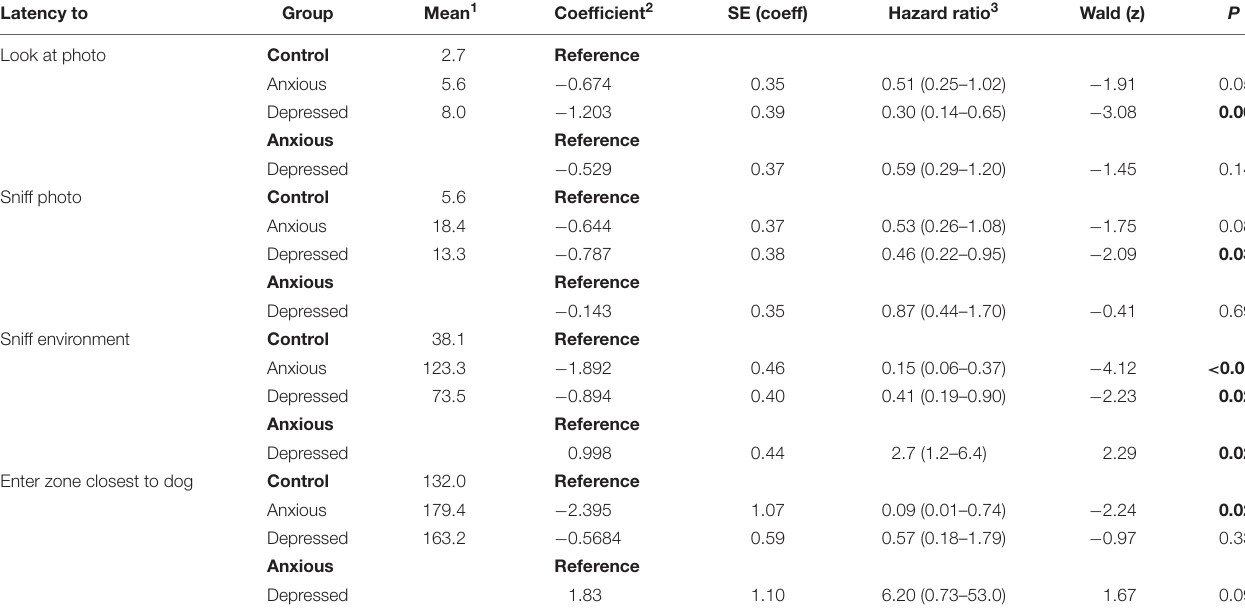
TABLE 6 | Hazard ratios for latency to look at the photo, sniff the photo, sniff the environment, and enter the zone closest to the dog window as affected by treatment group. Latency to